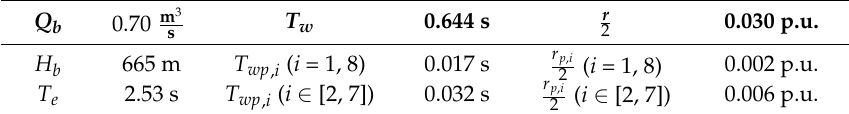
Table A2. Hydraulic system parameters.